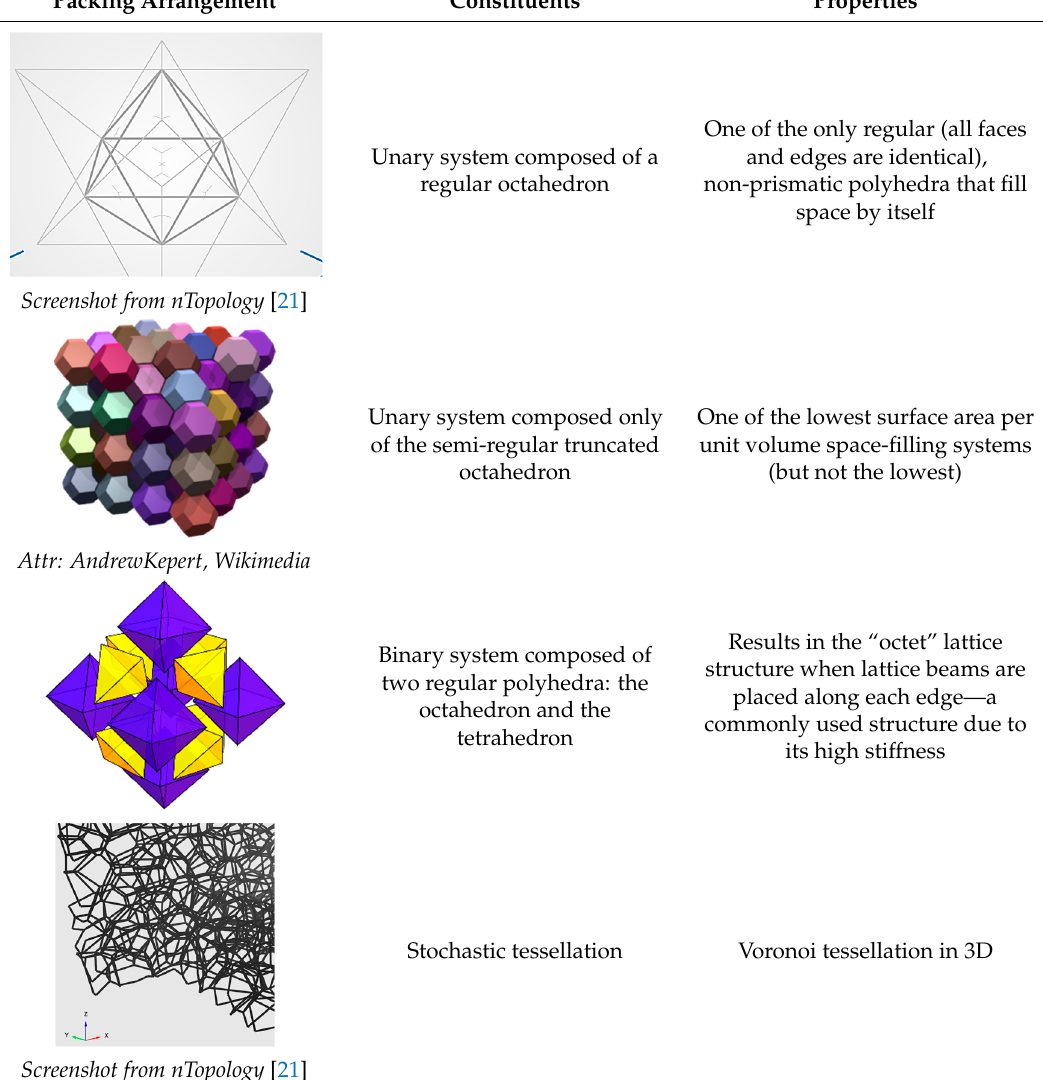
Table 2. Examples of 3D space-filling with non-prismatic polyhedra.